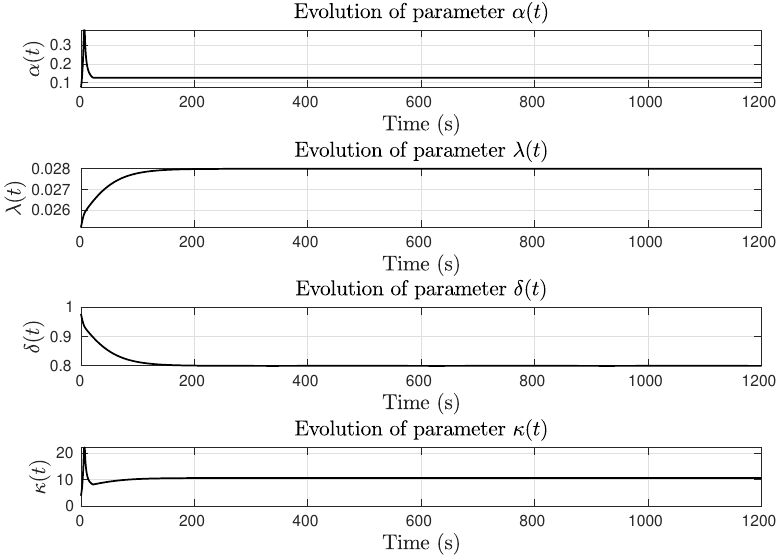
Figure 10. Sinusoidal yaw reference test with d ( t ) = 0. Adaptive parameters